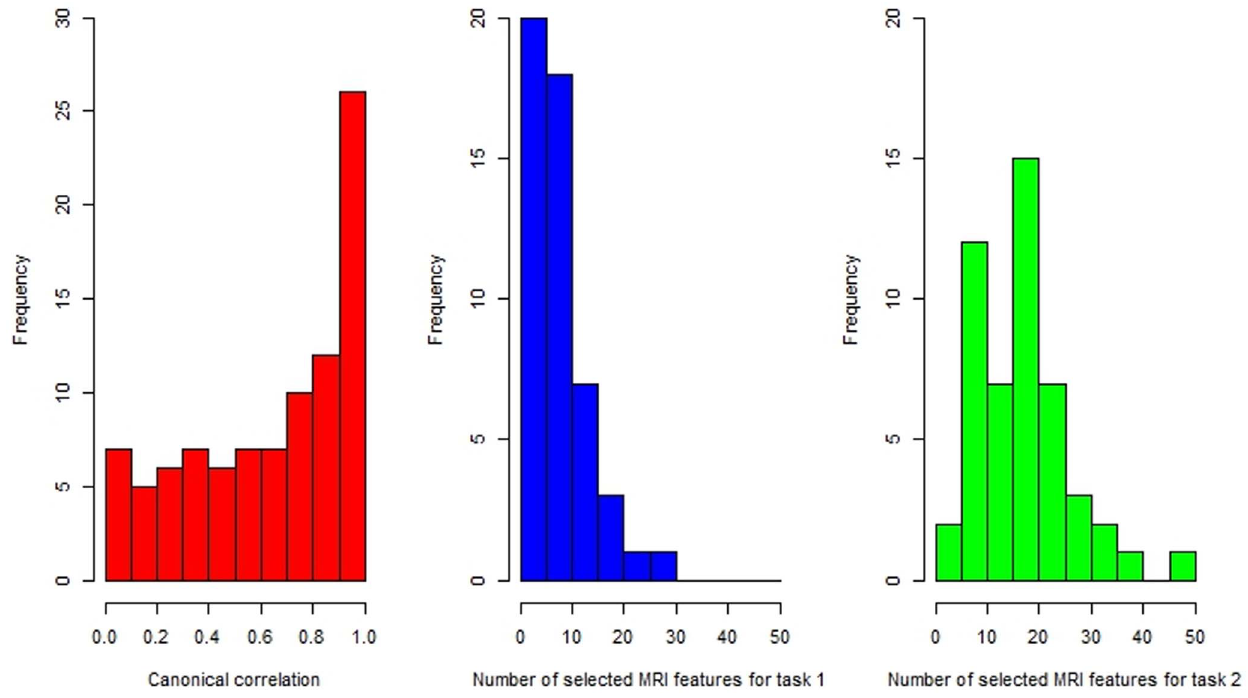
Figure 1. Left : Histogram of the canonical correlations between MRI features and PET features; Middle : Histogram of the number of selected MRI features for task 1 based on 50 times simulation. Each time we chose 76 pMCI subjects and 76 sMCI subjects randomly in task 1; Right : Histogram of the number of selected MRI features for task 2 based on 50 times simulation. Each time we chose 76 pMCI subjects and 76 sMCI subjects randomly in task 2. For the middle and right plots, the LASSO method is used for feature selection and 10-fold cross validation is used to choose the optimal number of features.